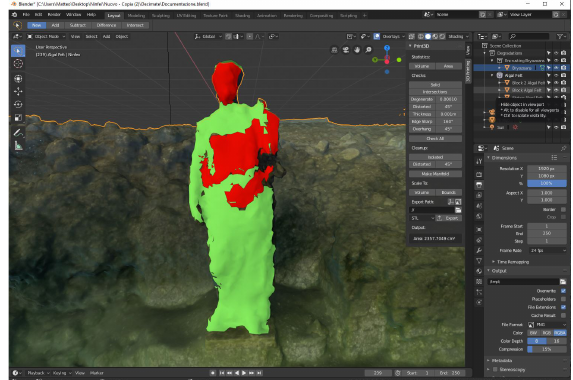
Figure 6. An example of 3D Mapping on the 3D model of Nymphaeum of Punta Epitaffio. Each colour is associated to a specific group of biological